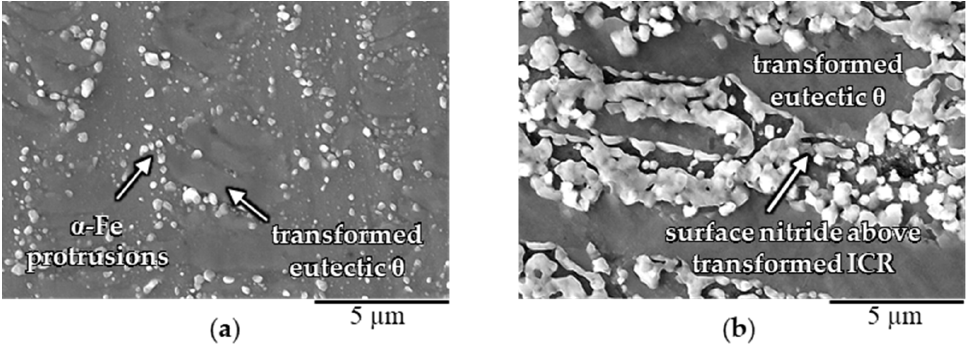
Figure 5. Top-surface SEM images (SE contrast) of remelted T-2.5Si-0.2Mn-0.1Cu after nitriding at 540 °C for 4 h with ( a ) K N = 0.1 atm − 1/2 , and ( b ) K N = 1 atm − 1/2 .